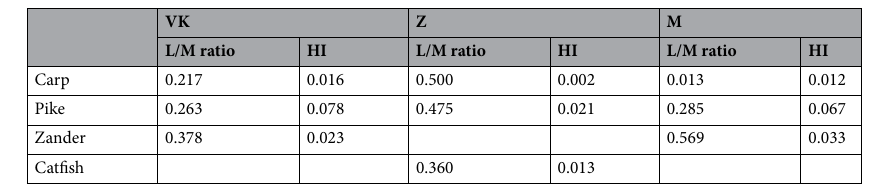
Table 4. Total mercury (THg) liver/muscle (L/M) ratios and Hazard index (HI) in carp, pike, zander and catfish caught in three ponds: Velky Kocelovicky (VK), Zehunsky (Z) and Mysliv (M). Where data are missing – indicated species was not caught in tht particular